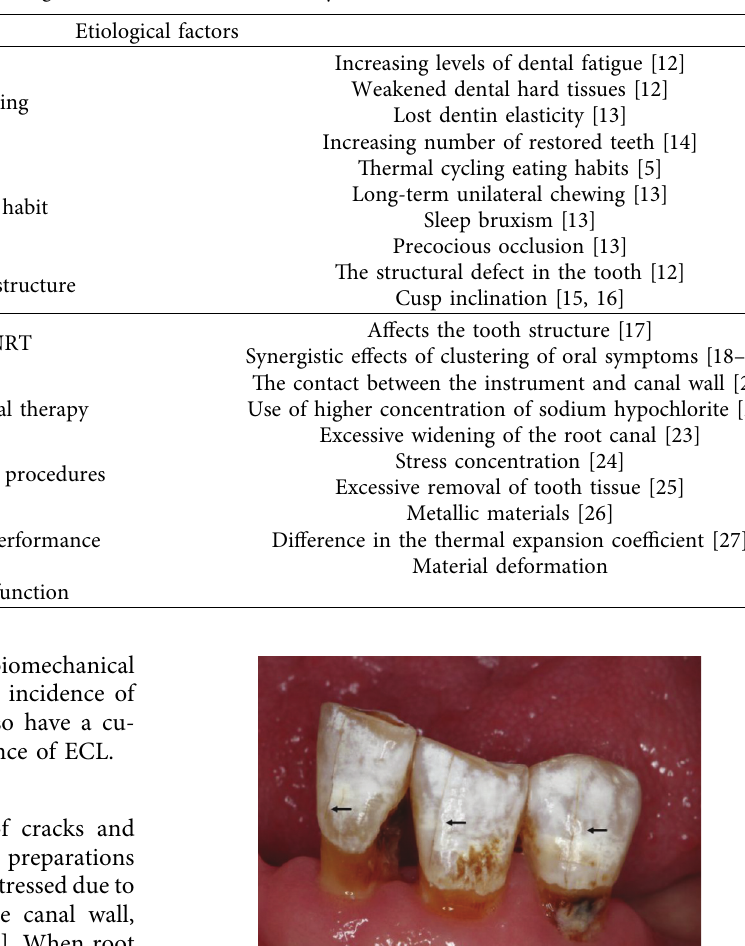
Table 1: Etiological factors of cracked tooth syndrome.